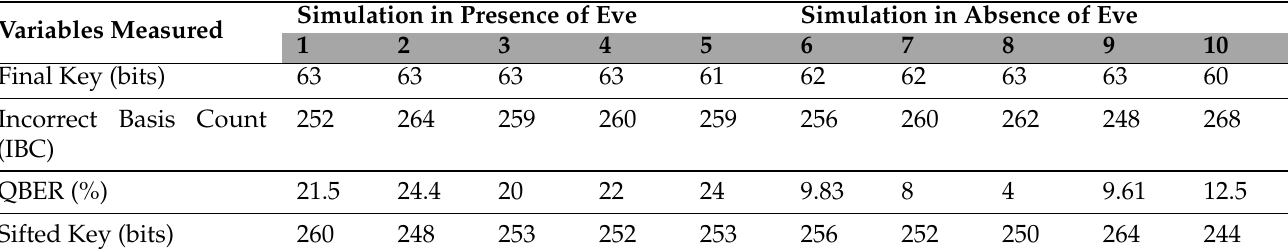
Table 4. Comparative Analysis of B92 in presence of Eve vs B92 in absence of Eve. Simulation in Presence of